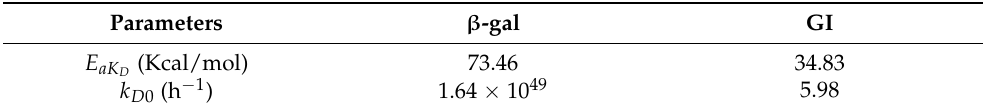
Table 2. Parameters of the Arrhenius equation for the determination of the inactivation rate (k D ) of β -galactosidase and glucose isomerase. Parameters β